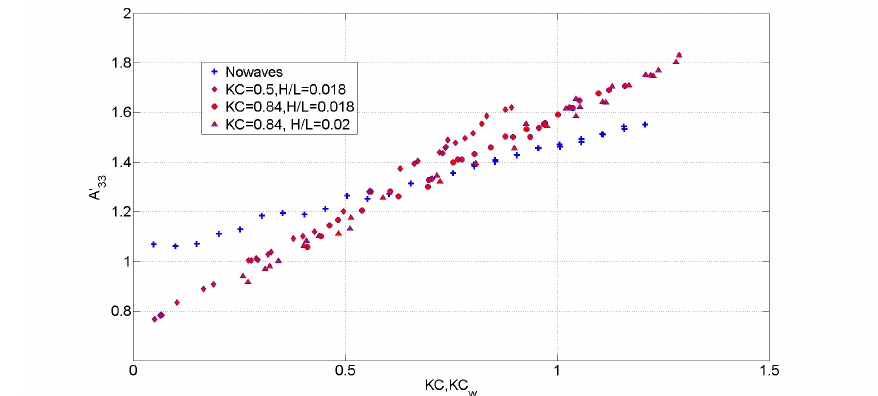
Figure 8. Comparison of the added mass coefficients in waves vs. KC w with those in still water vs. KC .